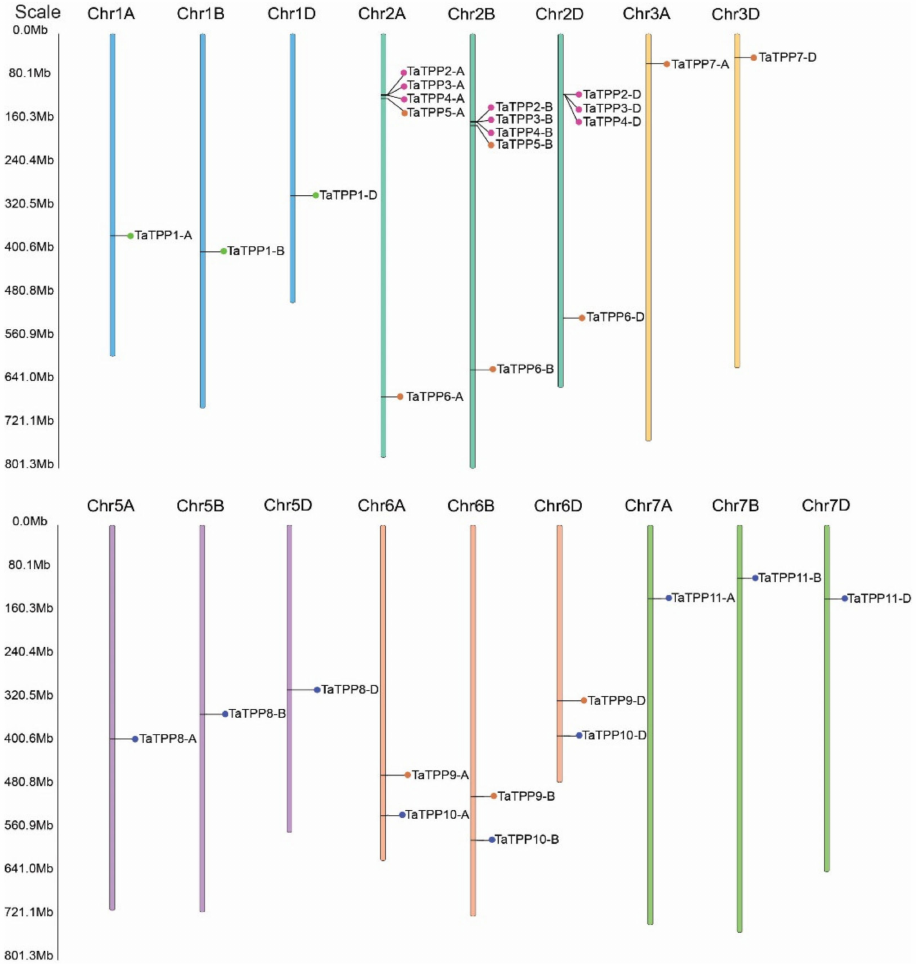
Figure 2. Graphical presentations of TaTPPs chromosomal distribution of on wheat chromosomes. The name of the gene on the right side and the location of the TaTPPs is indicated by the colored circular circle on the chromosomes. The three subgenomes chromosomal numbers are shown at the top of each